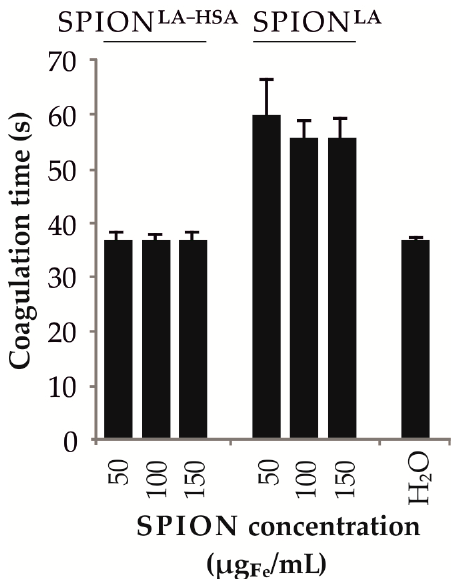
Figure 8. Influence of SPIONs on plasma coagulation. SPION LA-HSA and SPION LA were added to citrate-stabilized human blood at increasing concentrations. H 2 O served as control. After addition of aPTT solution, coagulation was induced by CaCl 2 solution and coagulation time was automatically measured. Abbreviations: SPION, superparamagnetic iron oxide nanoparticles; SPION LA , lauric acid-coated SPIONs; SPION LA-HSA , lauric acid- and human serum albumin-coated SPIONs; aPPT, activated partial thromboplastin time.